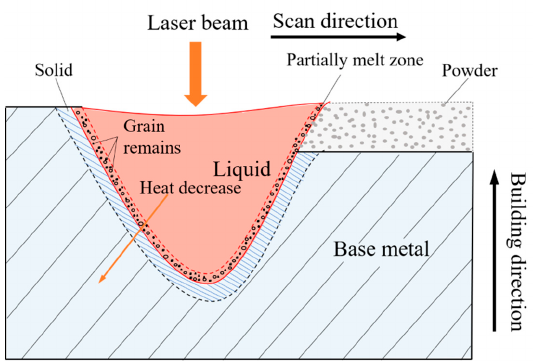
Figure 8. Schematic of the formation of the microstructure with three zones of the as-built